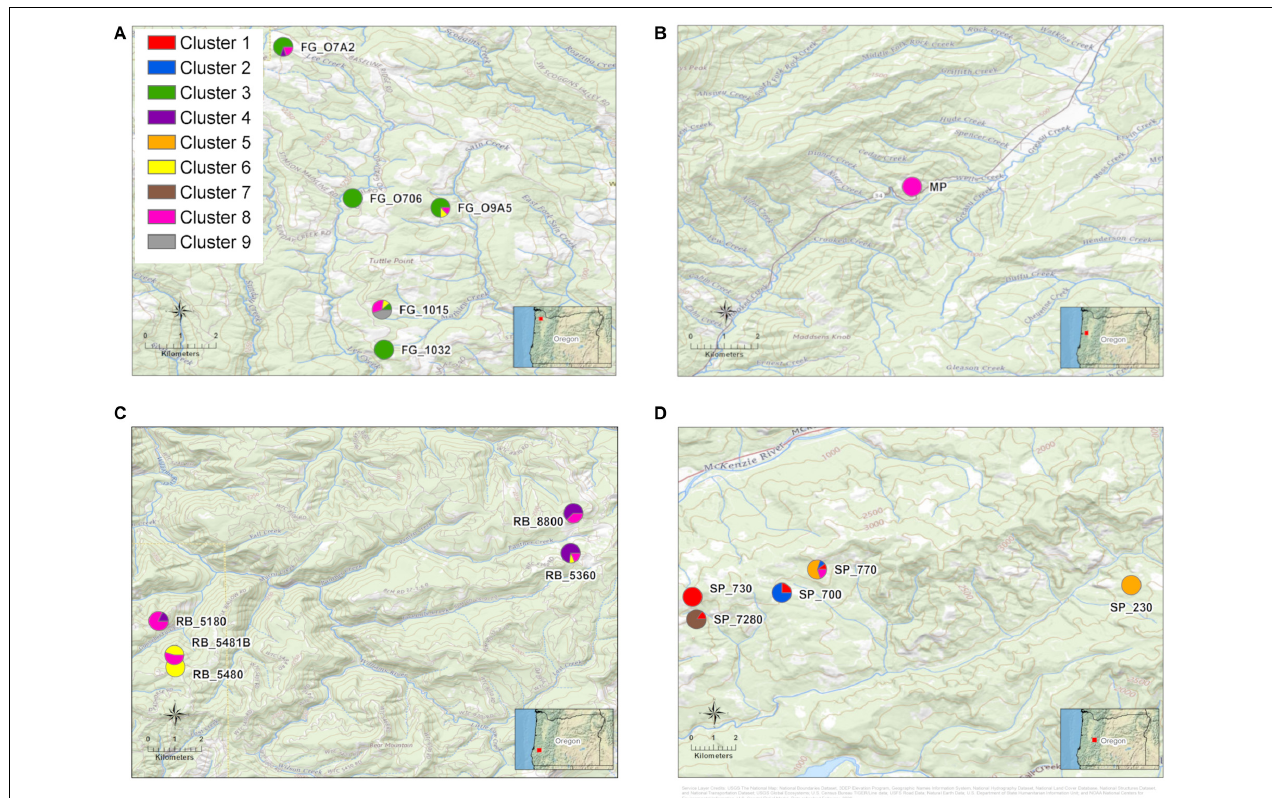
FIGURE 5 | Maps of stand locations within each Douglas-fir plantation with pie charts representing proportion of isolates in each of nine genetic clusters. Genetic clusters were assigned for all Leptographium wageneri var. pseudotsugae isolates with a K-means clustering algorithm. (A) Forest Grove (FG) plantation, (B) Mary’s Peak (MP) plantation, (C) Roseburg (RB) plantation, (D) Springfield (SP) plantation. Labels next to the pie charts represent the abbreviation for each plantation followed by the stand number. See Table 2 for sample sizes within stands and